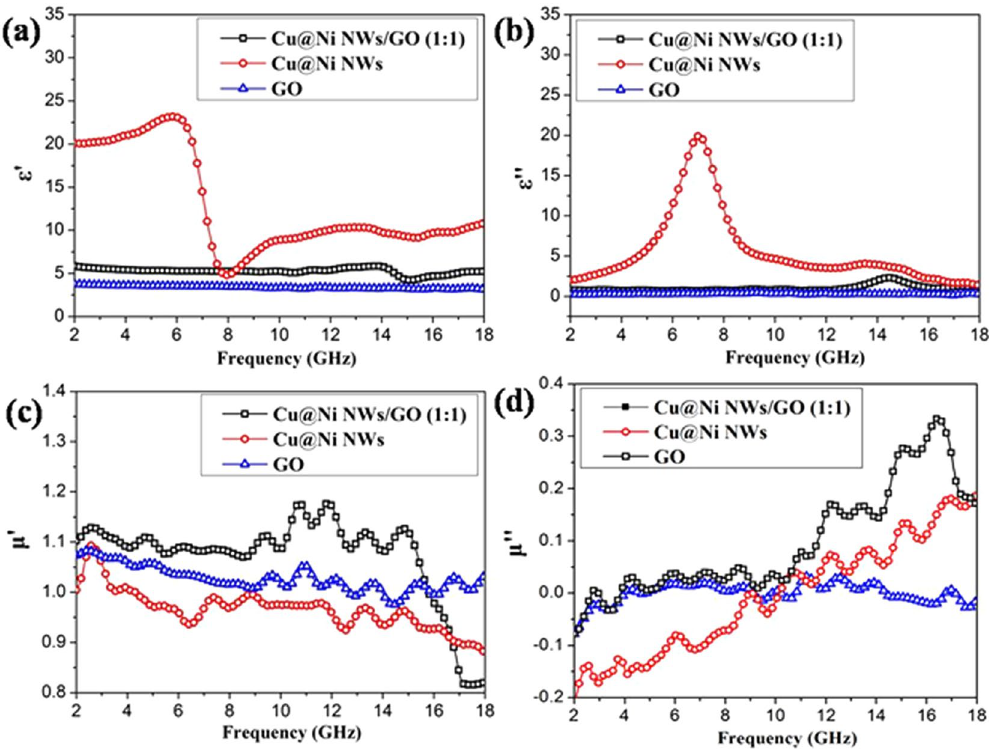
Figure 6. ( a , b ) Real ( ε′ ) and imaginary ( ε′′ ) parts of permittivity and ( c , d ) real ( μ′ ) and imaginary ( μ′′ ) parts of permeability for Cu@Ni NWs/GO (1:1), Cu@Ni NWs, and GO in the frequency range of 2.0–18.0